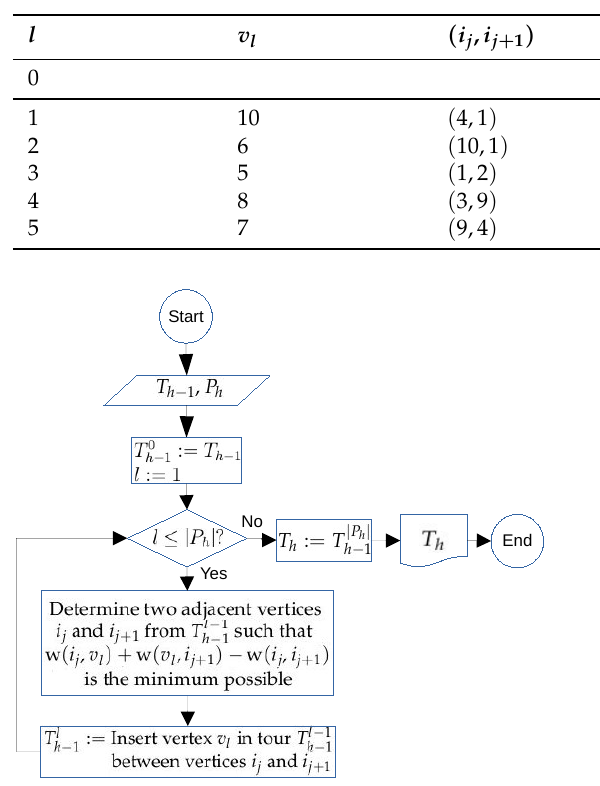
Figure 17. Joinp algorithm